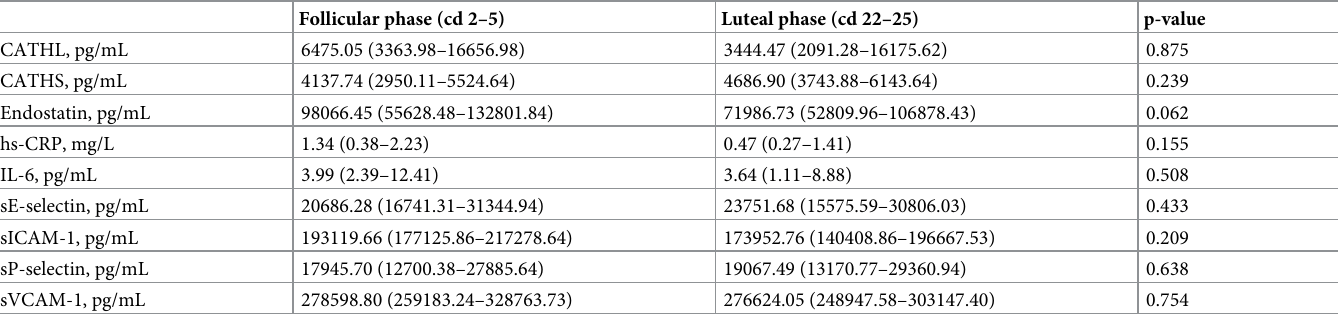
Table 1. Inflammatory and endothelial markers during follicular and luteal phase of menstrual cycle in patients with